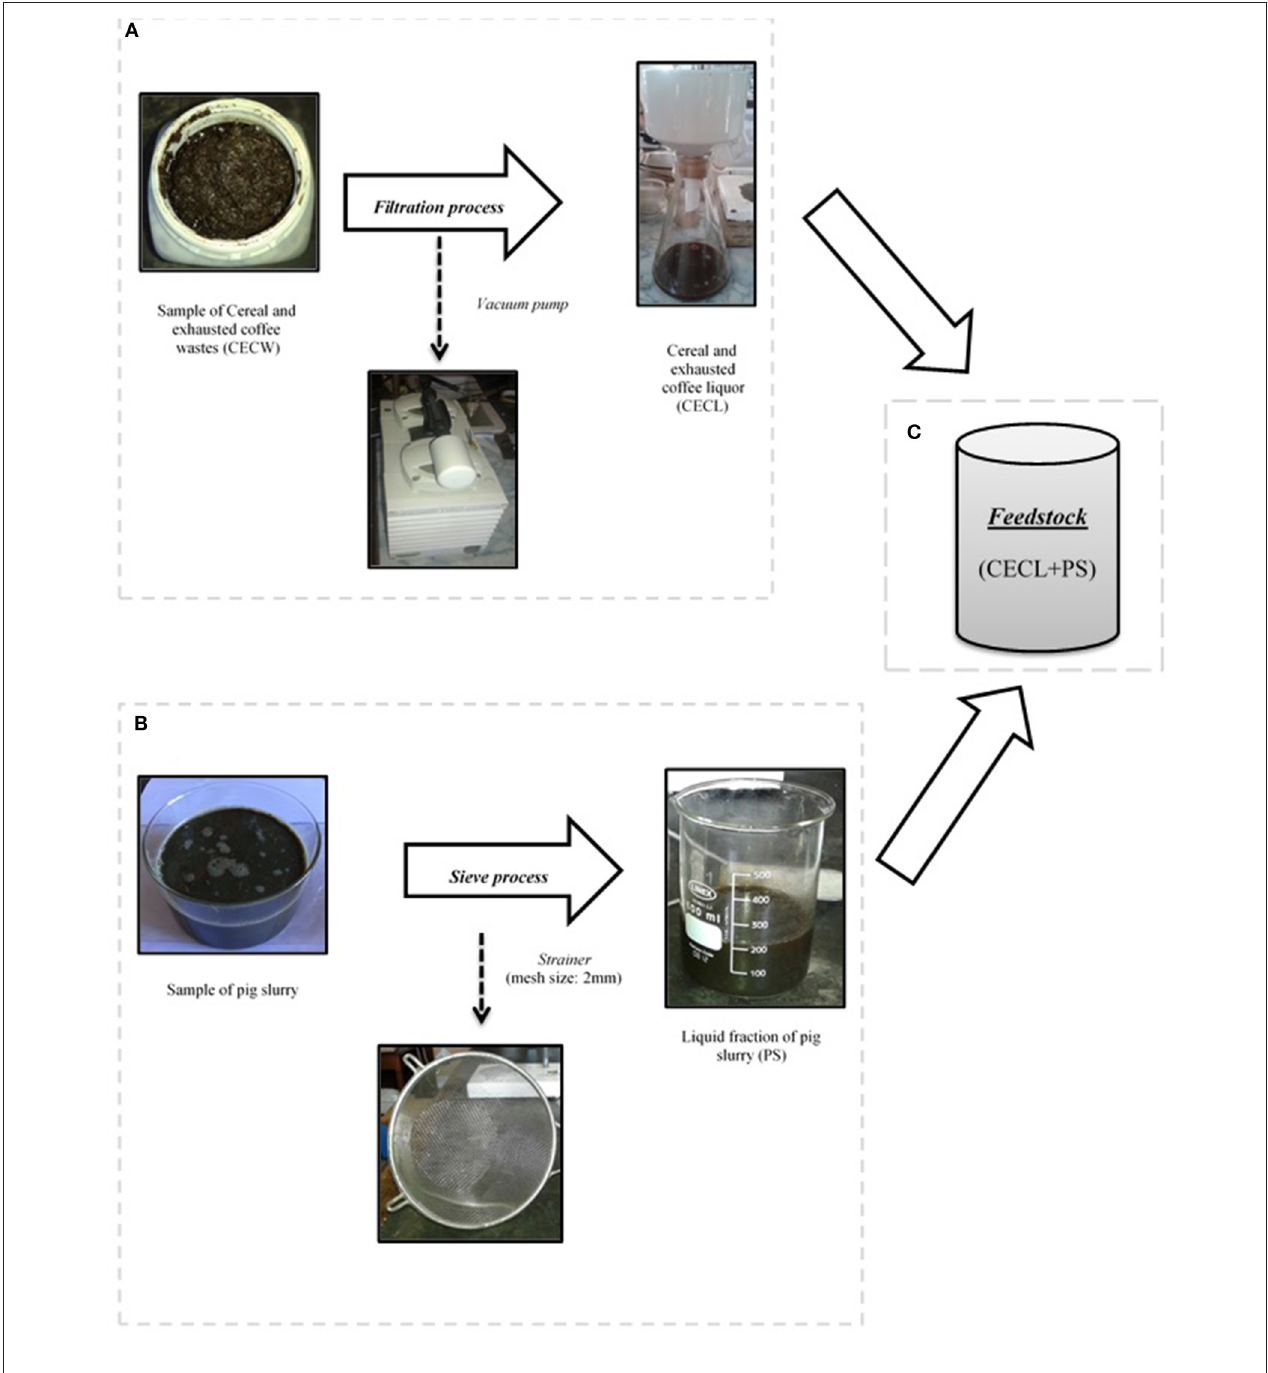
FIGURE 2 | Scheme of the mechanical pre-treatment process of CECW (A) and pig slurry (B) and preparation of feedstock samples (C) .